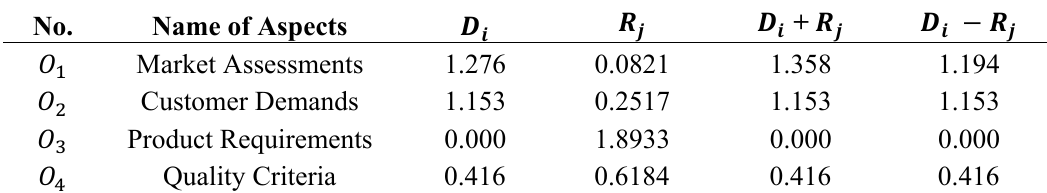
Table 5. Relevance and Impact between Aspects after